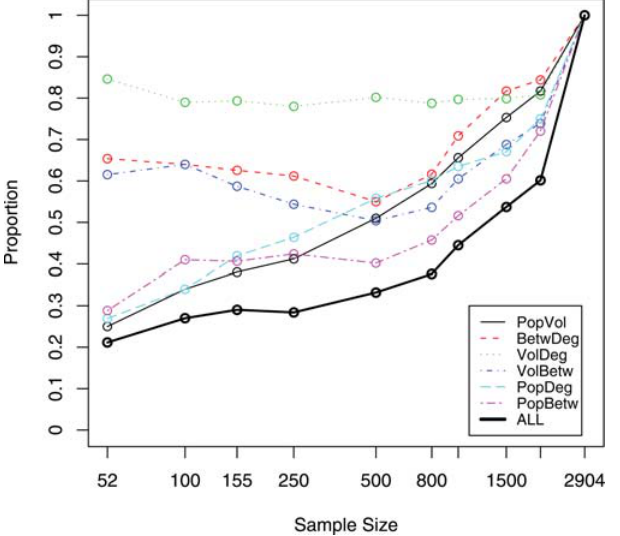
Figure 4. Proportion of cities sharing the top ranks between 2 or more characteristics. For each pair of network characteristics we consider 2 lists of cities ordered by each of the characteristics. The list size is shown on the horizontal axis. The proportion of cities shared by both lists is shown on the vertical axis. The minimum value of the shared proportion, 0, occurs when the lists have no city in common. The maximum value, 1, occurs when the two lists are identical. This is achieved only in the whole sample. For the 52 city lists, only 11 cities are among top 52 in all four characteristics.